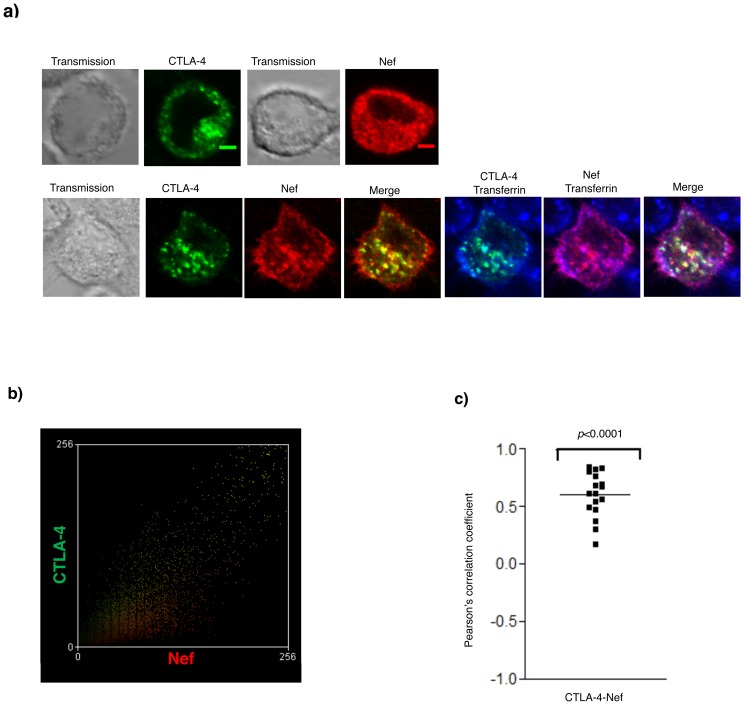
Nef and CTLA-4 co-localize in early and recycling endosomes.a) HeLa cells transfected only with a FLAG-Nef expression vector (upper panels) or co-transfected (lower panels) with CTLA-4 expressing vector were incubated with Alexa 633 labeled transferrin (blue), CTLA-4 specific antibody (green) and FLAG-Nef antibody (red). The extreme left panels show a transmission light field. The middle lower panel shows the co-localization between Nef and CTLA-4 (yellow color results from merging green (CTLA-4) and red (Nef)). The extreme right lower panel shows the co-localization of the three proteins; CTLA-4, Nef and transferrin together (the white color is a combination of green (CTLA-4), red (Nef) and blue (transferrin)), Bar = 20 µm. b) Scatter diagram showing the intensity of the CTLA-4-Alexa-fluor 488 (Y-axis) and Nef-Alexa-fluor 546 (X-axis). c) Levels of co-localization between CTLA-4 and Nef is represented by the mean Pearson's correlation coefficient (Rr) (n = 16, 9 fields).